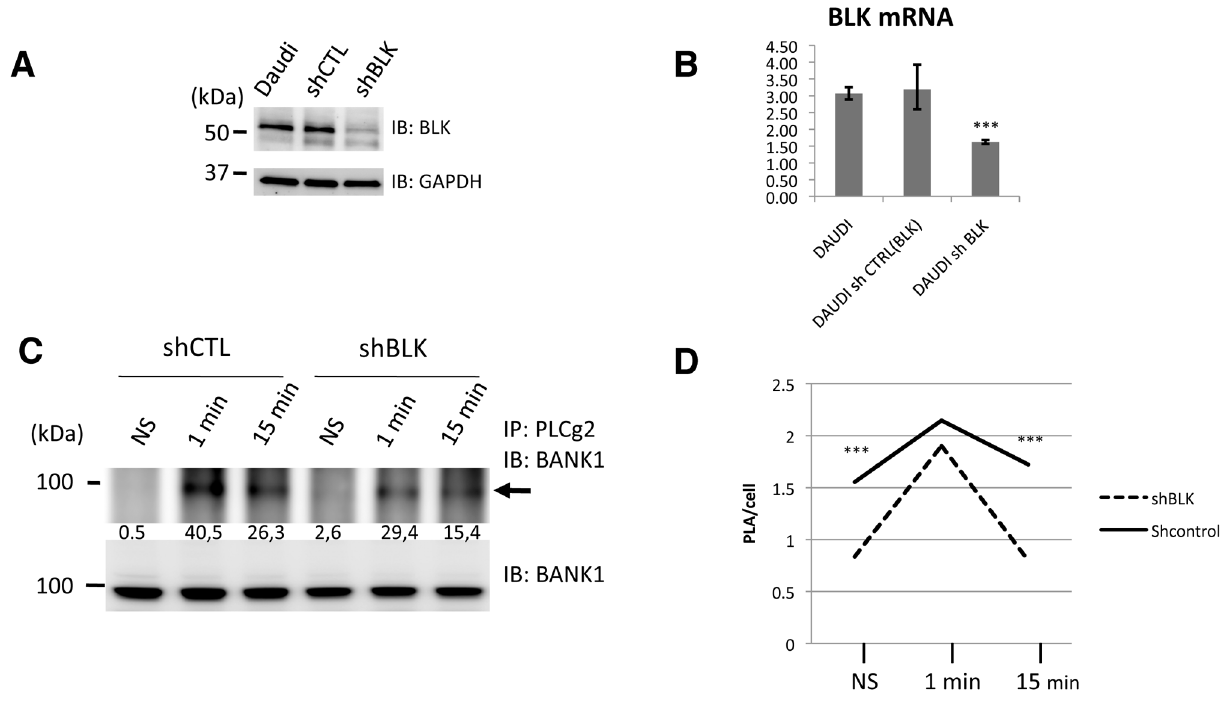
Figure 5. Silencing of the BLK kinase leads to alteration of the association between BANK1 and PLCg2. (A) Immunoblot of extracts derived from human Daudi B-cells showing efficient silencing of endogenous BLK protein. The cell line shBLK was transduced with lentivirus coding for small hairpin RNAs targeting the BLK kinase while shControl lentivirus codes for unrelated sequences. Top, western blot analysis using antibody to BLK; bottom, western blot analysis using antibody to GAPDH as loading control. (B) The relative BLK mRNA is reduced to half in the silencing line (shBLK)(***P , 0,001 based on Students test comparing mRNA expression between Daudi cell versus cBLK silencing cells and control silenced cells versus BLK silencing cells). (C) Immunoprecipitates (IPs) of stimulated silenced shBLK cells with anti-IgM, using anti-PLCg2 antibody and interrogated with anti-BANK1 to assay BANK1-PLCg2 association. Quantification of the immunoprecipitates normalized with BANK1 is displayed below the bands. Silencing of BLK leads to less association between BANK1-PLCg2. (D) Kinetics of the association between BANK1-PLCg2 assayed with in situ Proximity Ligation (PLA) in control and BLK-silenced cell lines. The association between BANK1-PLCg2 is reduced in silenced cells during resting conditions and after 15 minutes of IgM stimulation (***P # 0,001 based on Students test comparing control cells versus BLK silencing cells). The difference of BANK1- PLCg2 association between control and the silenced lines was not significant at 1 minute after stimulation.